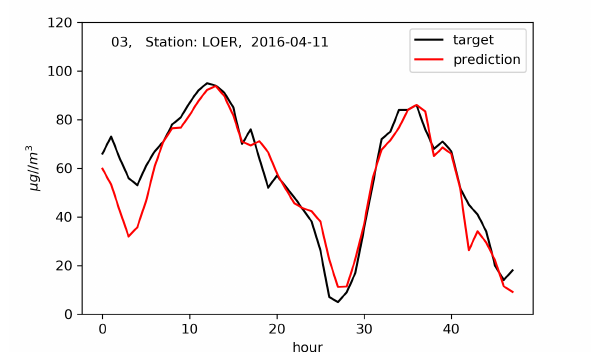
Figure 10. O 3 prediction, station LOER (L1-Loss: 6.04)